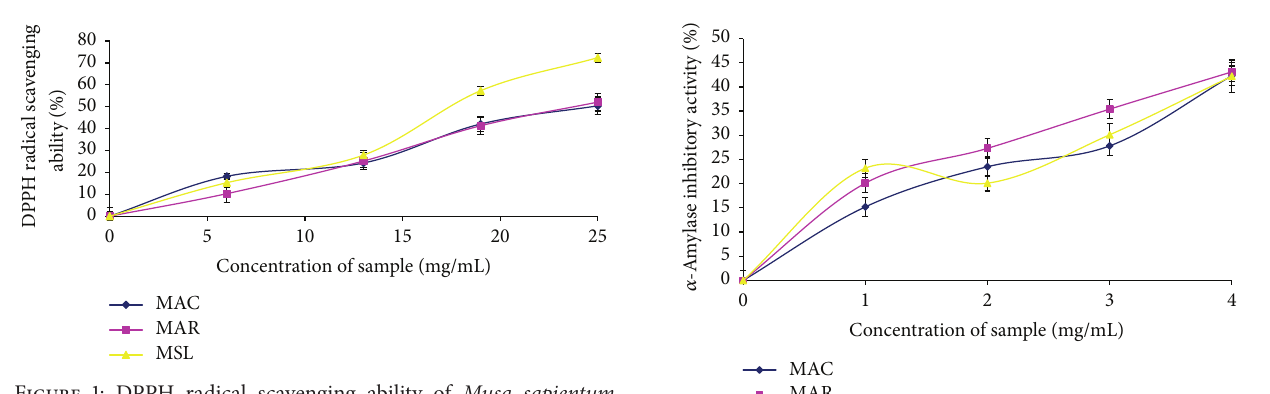
Figure 1: DPPH radical scavenging ability of Musa sapientum (Latundan banana) (MSL), Musa acuminata (Cavendish banana) (MAC), and Musa acuminate (Red Dacca) (MAR).